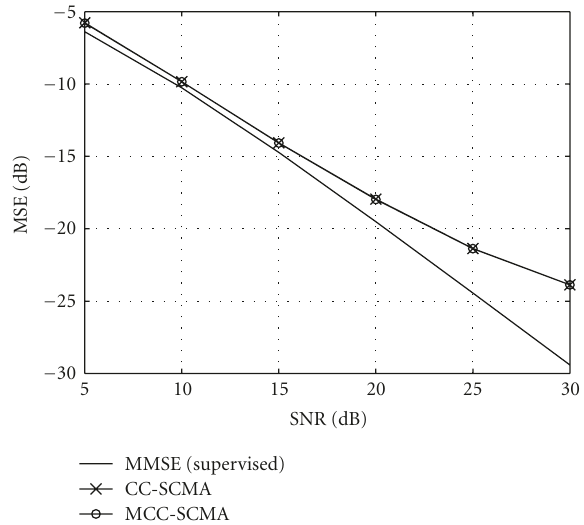
Figure 5: MSE versus SNR of CC-SCMA, MCC-SCMA, and super- vised